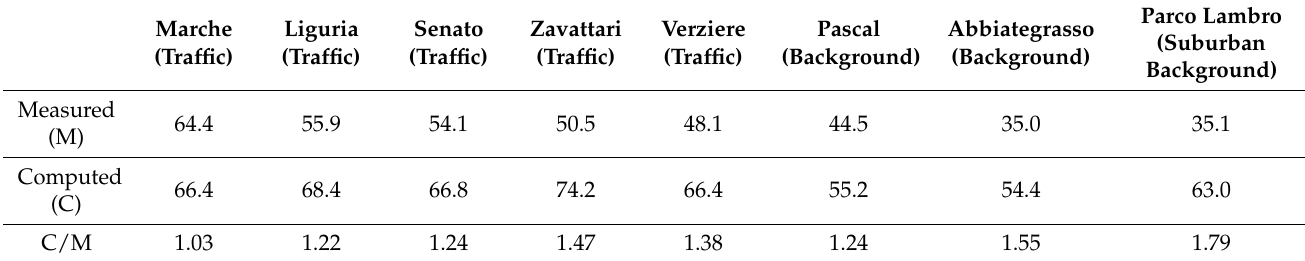
Table 5. Yearly NO 2 concentrations ( µ g/m 3 ) calculated by the model compared with measurements at urban and suburban air quality stations. Actual